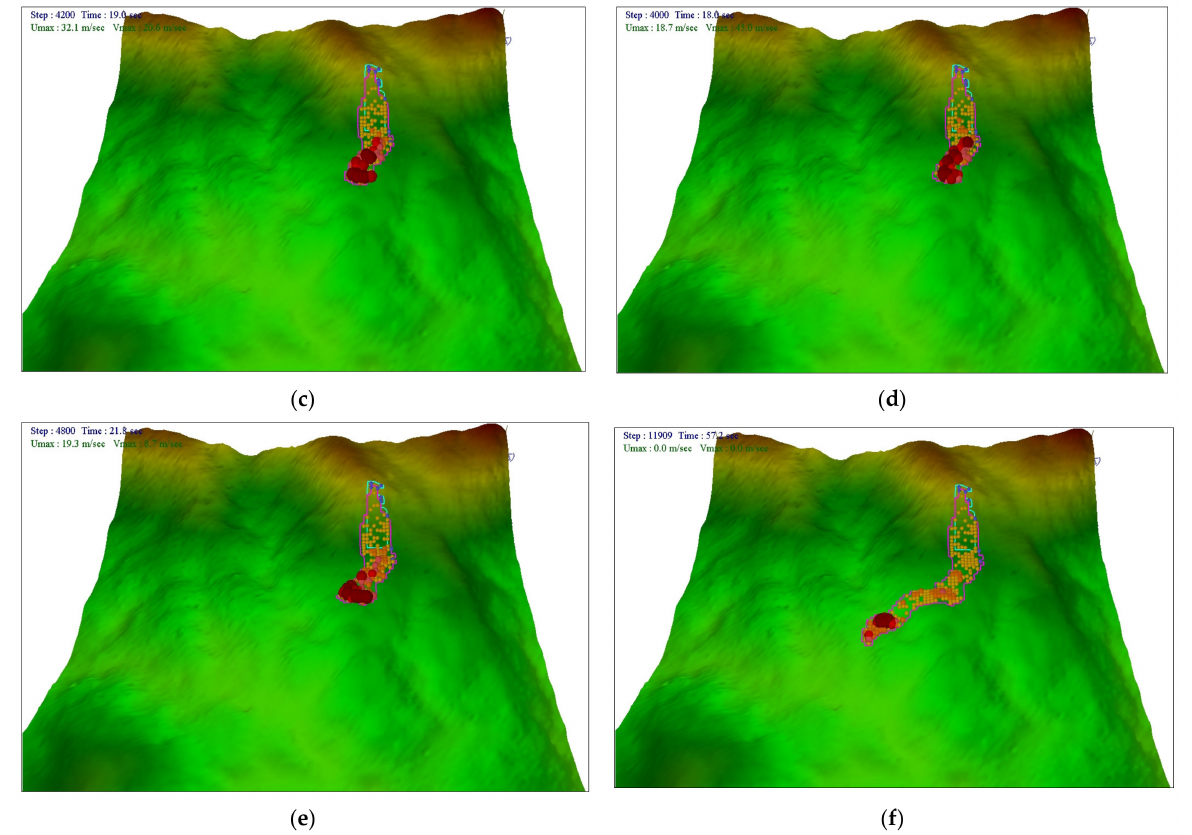
Figure 14. Simulation of Upputhode landslide for finding the mechanisms of ( a ) landslide initiation, ( b – d ) landslide motion and ( e , f ) deposition of debris mass.